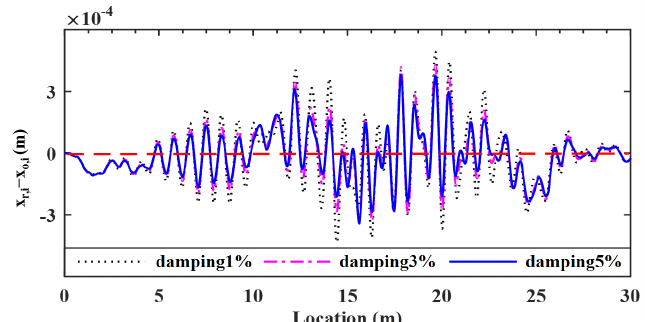
Figure 15. Deviations of surface profiles identified for different bridge damping ratios.